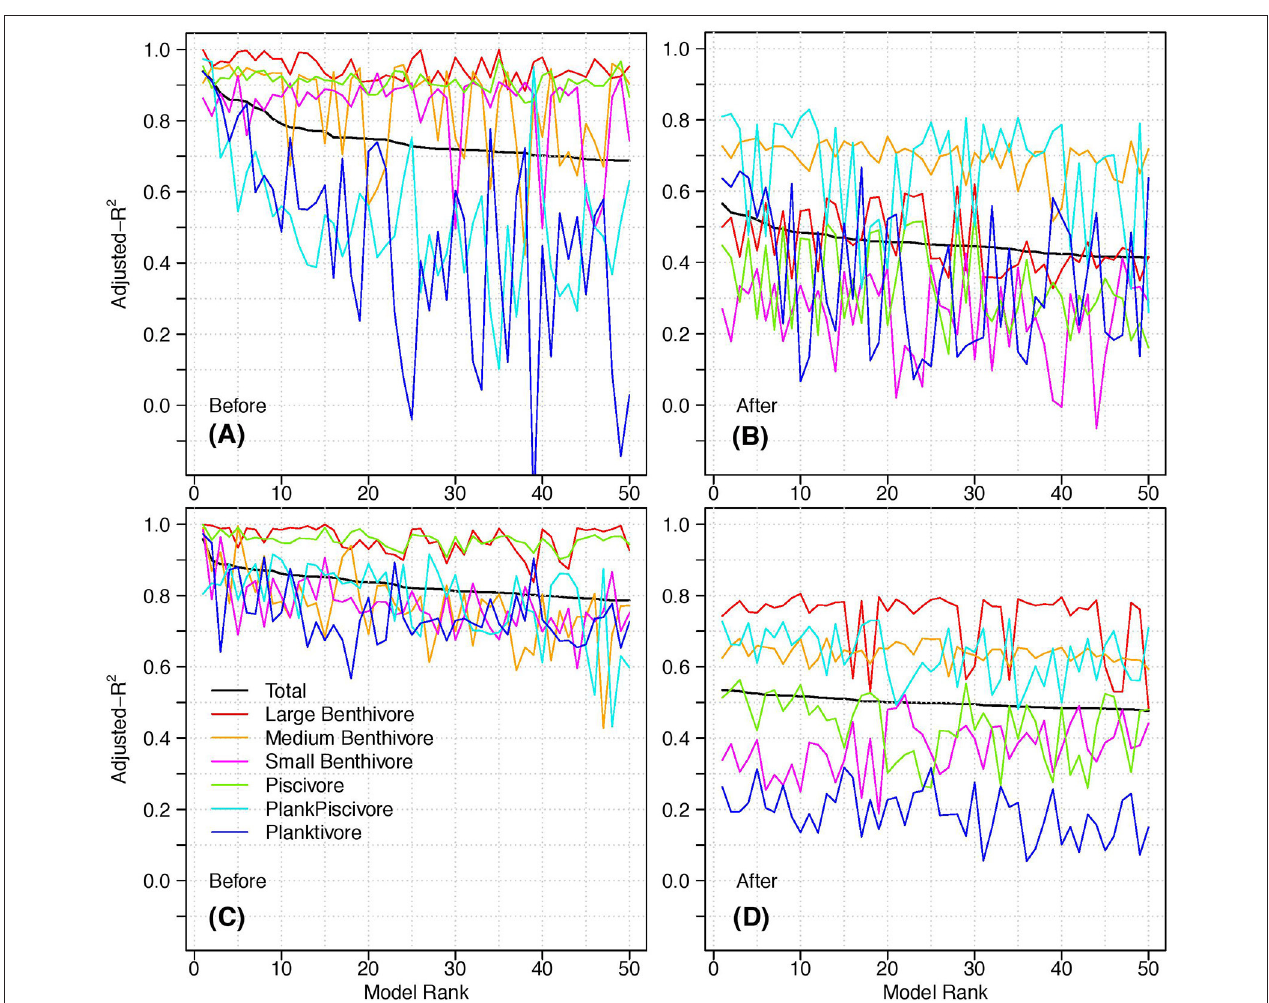
FIGURE 6 | The adjusted-R 2 Total of the top 50 models and corresponding adjusted-R 2 of each functional group for (A) Before models, ZD predictors; (B) After models, ZD predictors; (C) Before models, Avg1 predictors; (D) After models, Avg1 predictors. The legend is the same for each panel.